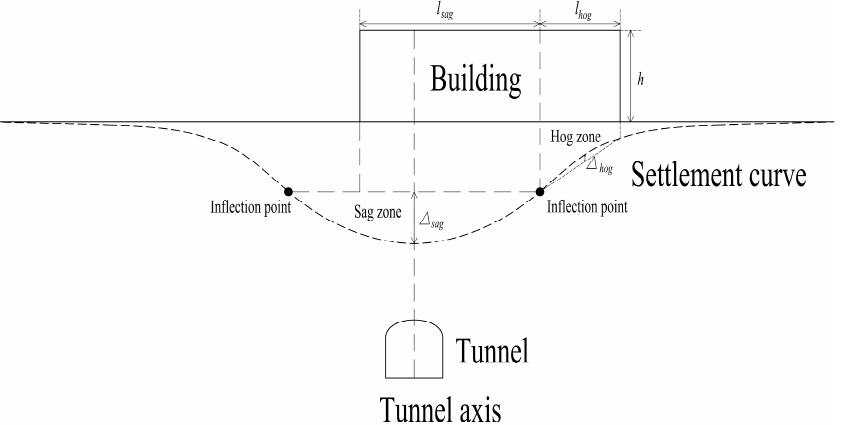
Figure 3. Schematic diagram of the ground surface settlement and building deformation after a tunnel excavation.